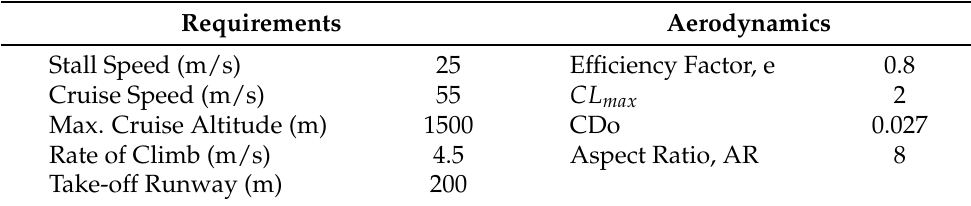
Table 4. Mission and performance requirements.